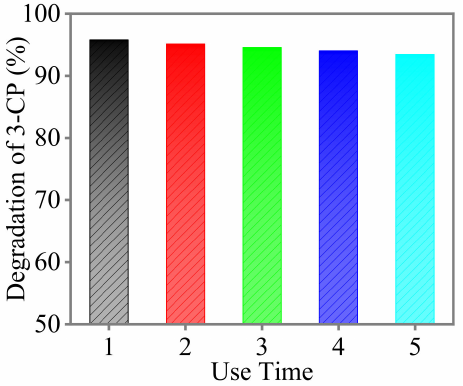
Figure 15. Reuse of Pd/CF in electro-reductive